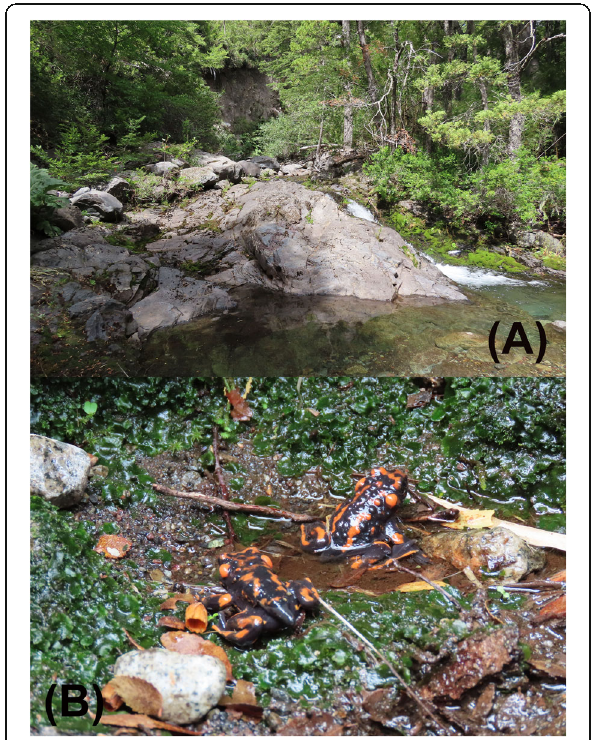
Fig. 2 a Hábitat de T. venustus en sector Altos de Malalcura, corresponde a una zona de pendiente suave y aguas lóticas con temperaturas de 10 a 12 °C en verano. b Los individuos fueron encontrado bajos rocas sobre sustrato de Briophytas y Hepáticas. a Habitat of T. venustus in Malalcura, corresponds to an area with a gentle slope and lotic waters with 10 to 12 °C in summer. b The individuals were found under rocks on Bryophyte and Hepatic substrate